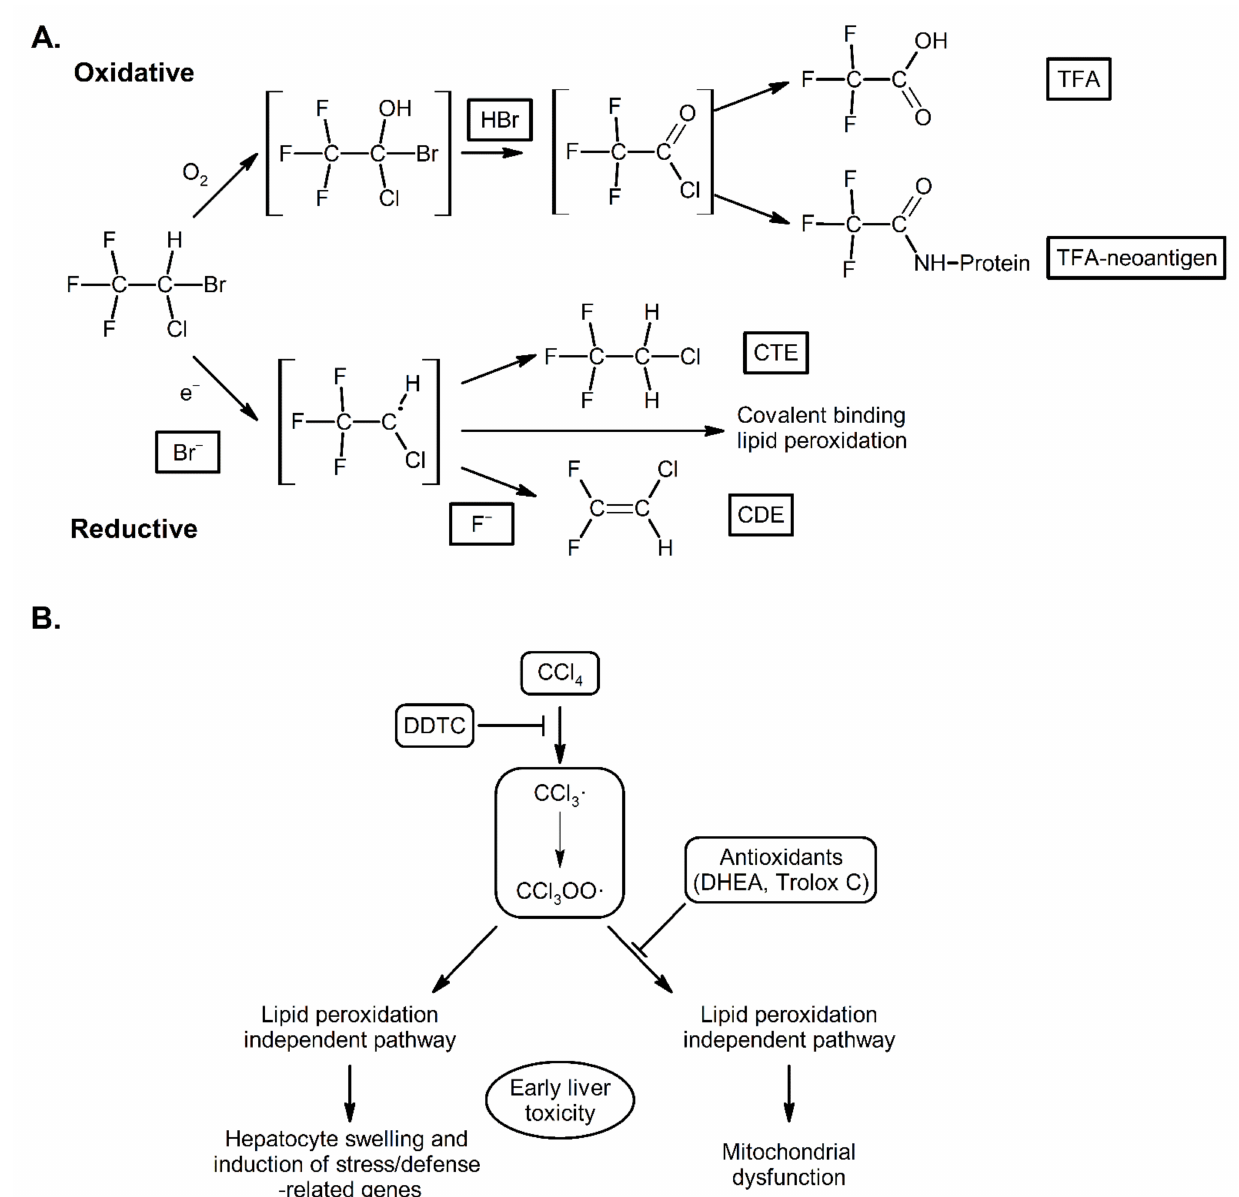
Figure 3. Mechanisms of CYP2E1 dependent oxidation and reduction of halothane [60,61] ( A ) and carbon tetrachlo- ride [62] ( B ). Aerobically, halothane undergoes cytochrome P450 catalyzed oxidation to trifluoroacetic acid (TFA), bromide and a reactive intermediate that can acetylate liver proteins and produces neo-antigens which stimulate an immune reaction that mediates severe hepatic necrosis. Anaerobically, halothane is reduced to a radical that can generate the metabolites chlorotrifluoroethane (CTE) and chlorodifluoroethylene (CDE) and also covalently bind proteins generating autoimmune reactions and also induce lipid